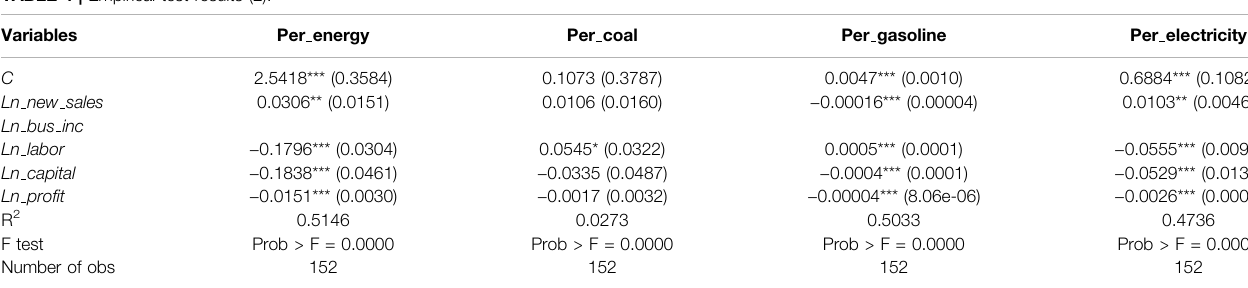
TABLE 4 | Empirical test results